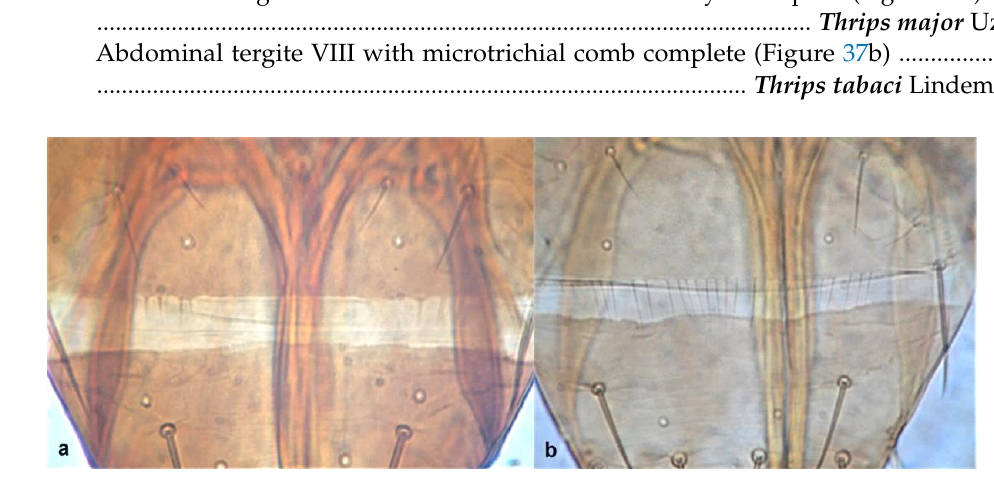
Figure 37. Abdominal tergite VIII : ( a ) medially incomplete; ( b ) complete.